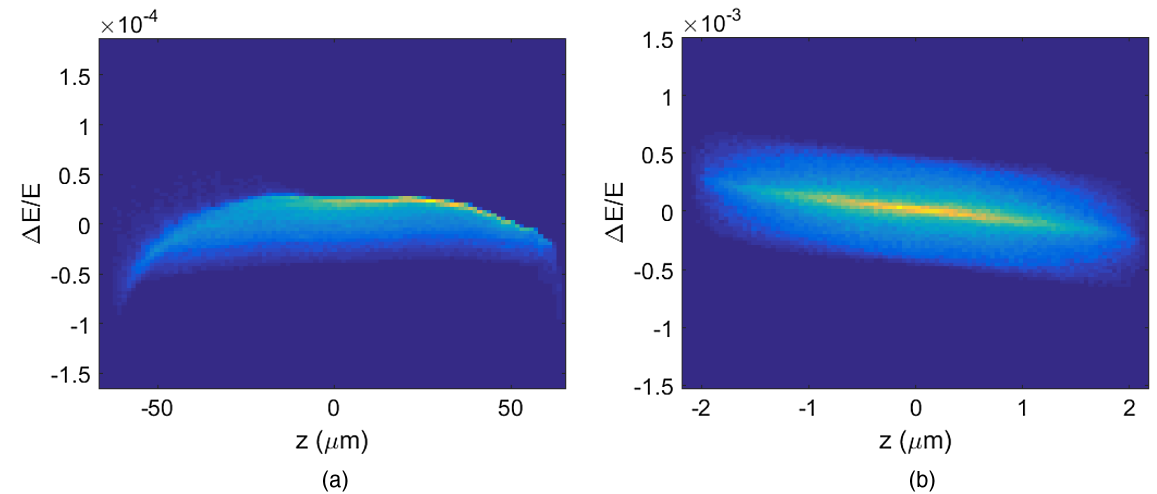
FIG. 8. The relative density of the electron bunch for the longitudinal phase space (a) before and (b) after emittance